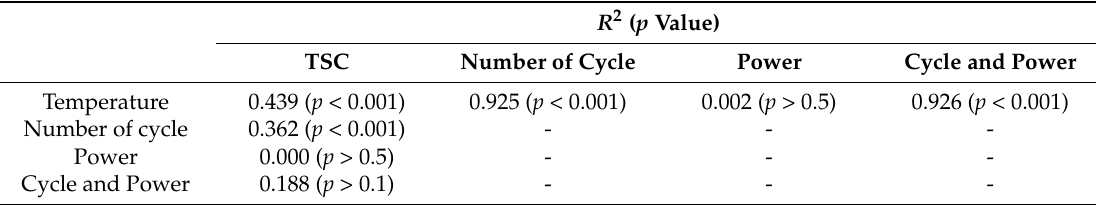
Table 1. Correlations between the TSC and the MAE parameters. R 2 ( p